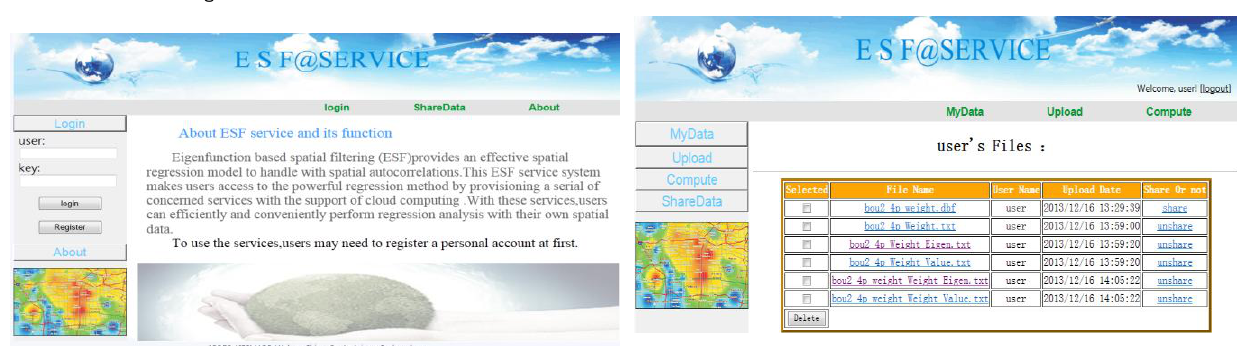
Figure 5. The portal site of ESF service system